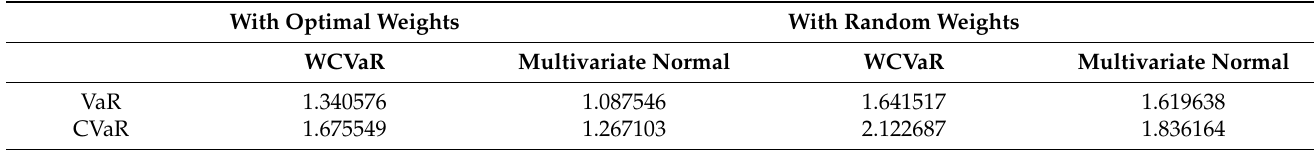
Table 1. Comparison between the traditional multivariate normal method and WCVaR technique. With Optimal Weights